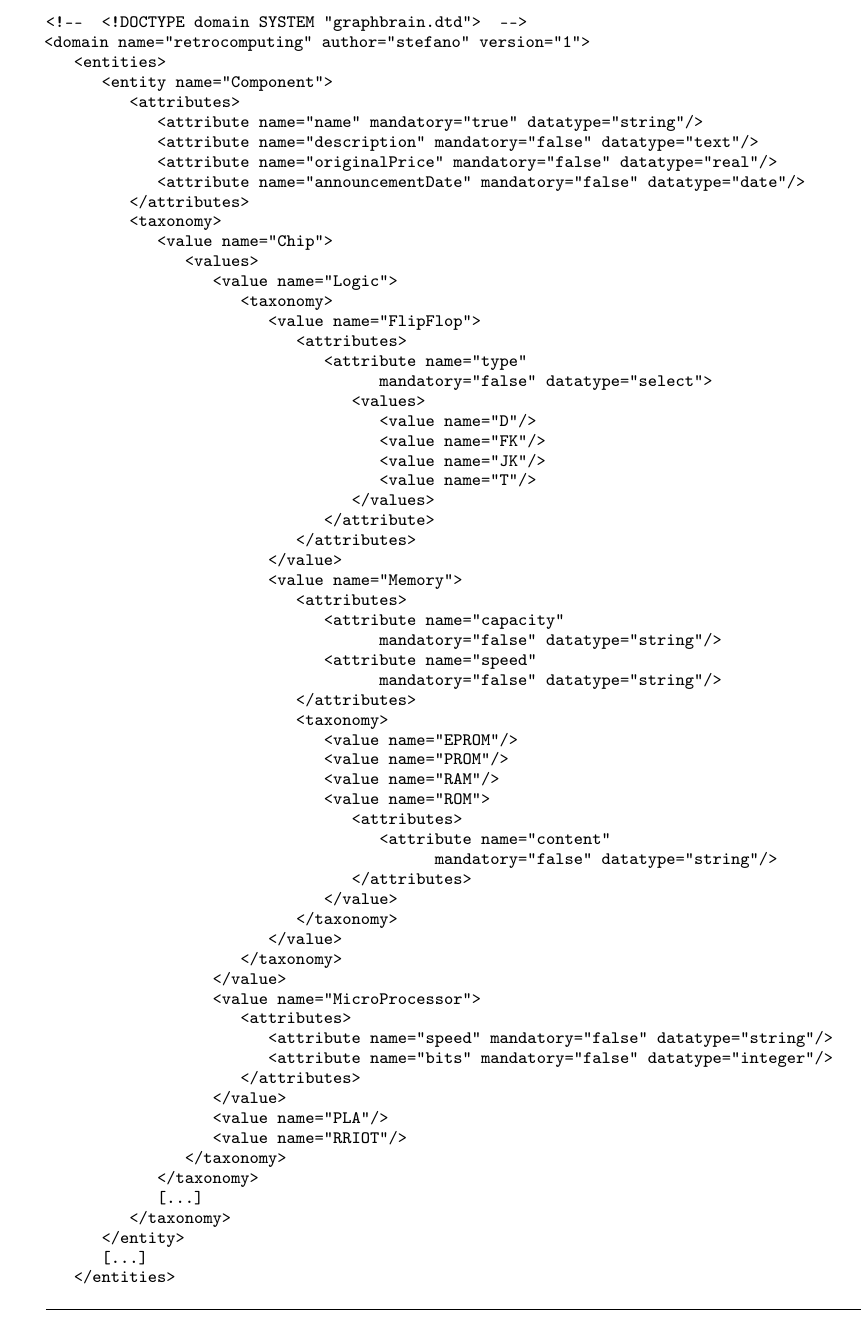
Table 3. Sample fragment of ontology in GraphBRAIN format (part